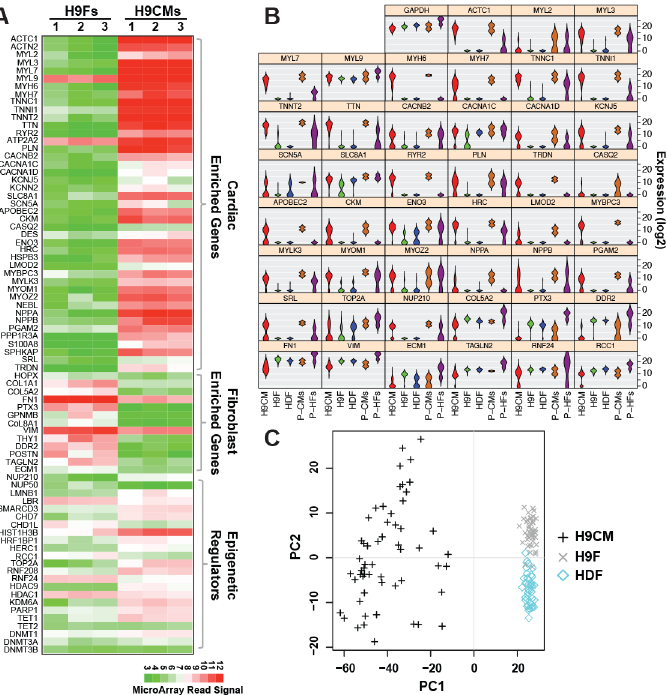
Fig 2. Validation of 96 TaqMan ® primers/probes for single-cell qPCR in individual H9CMs (n = 56), H9Fs (n = 45), and HDFs (n = 41). Pooledsamplesof H9CMs and humanfibroblasts (P-CMs and P-HFs) were used as positive controls. A) Heatmap of geneexpressionprofiles in our microarray assay of H9Fs and H9CMs. B) A panel of 46 primers/probes had sufficient efficiency and sensitivity for single-cellqPCR. C) A principalcomponentanalysis(PCA) displayeda globalview of the expressionprofile of those 46 genes in individual H9CMs, H9Fs, and HDFs.